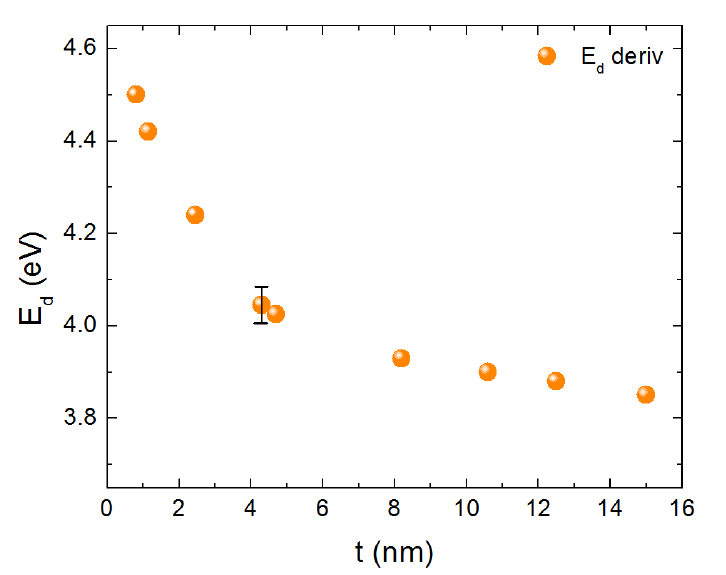
Figure 5. Position of E d as a function of energy. The data reveal a “blue